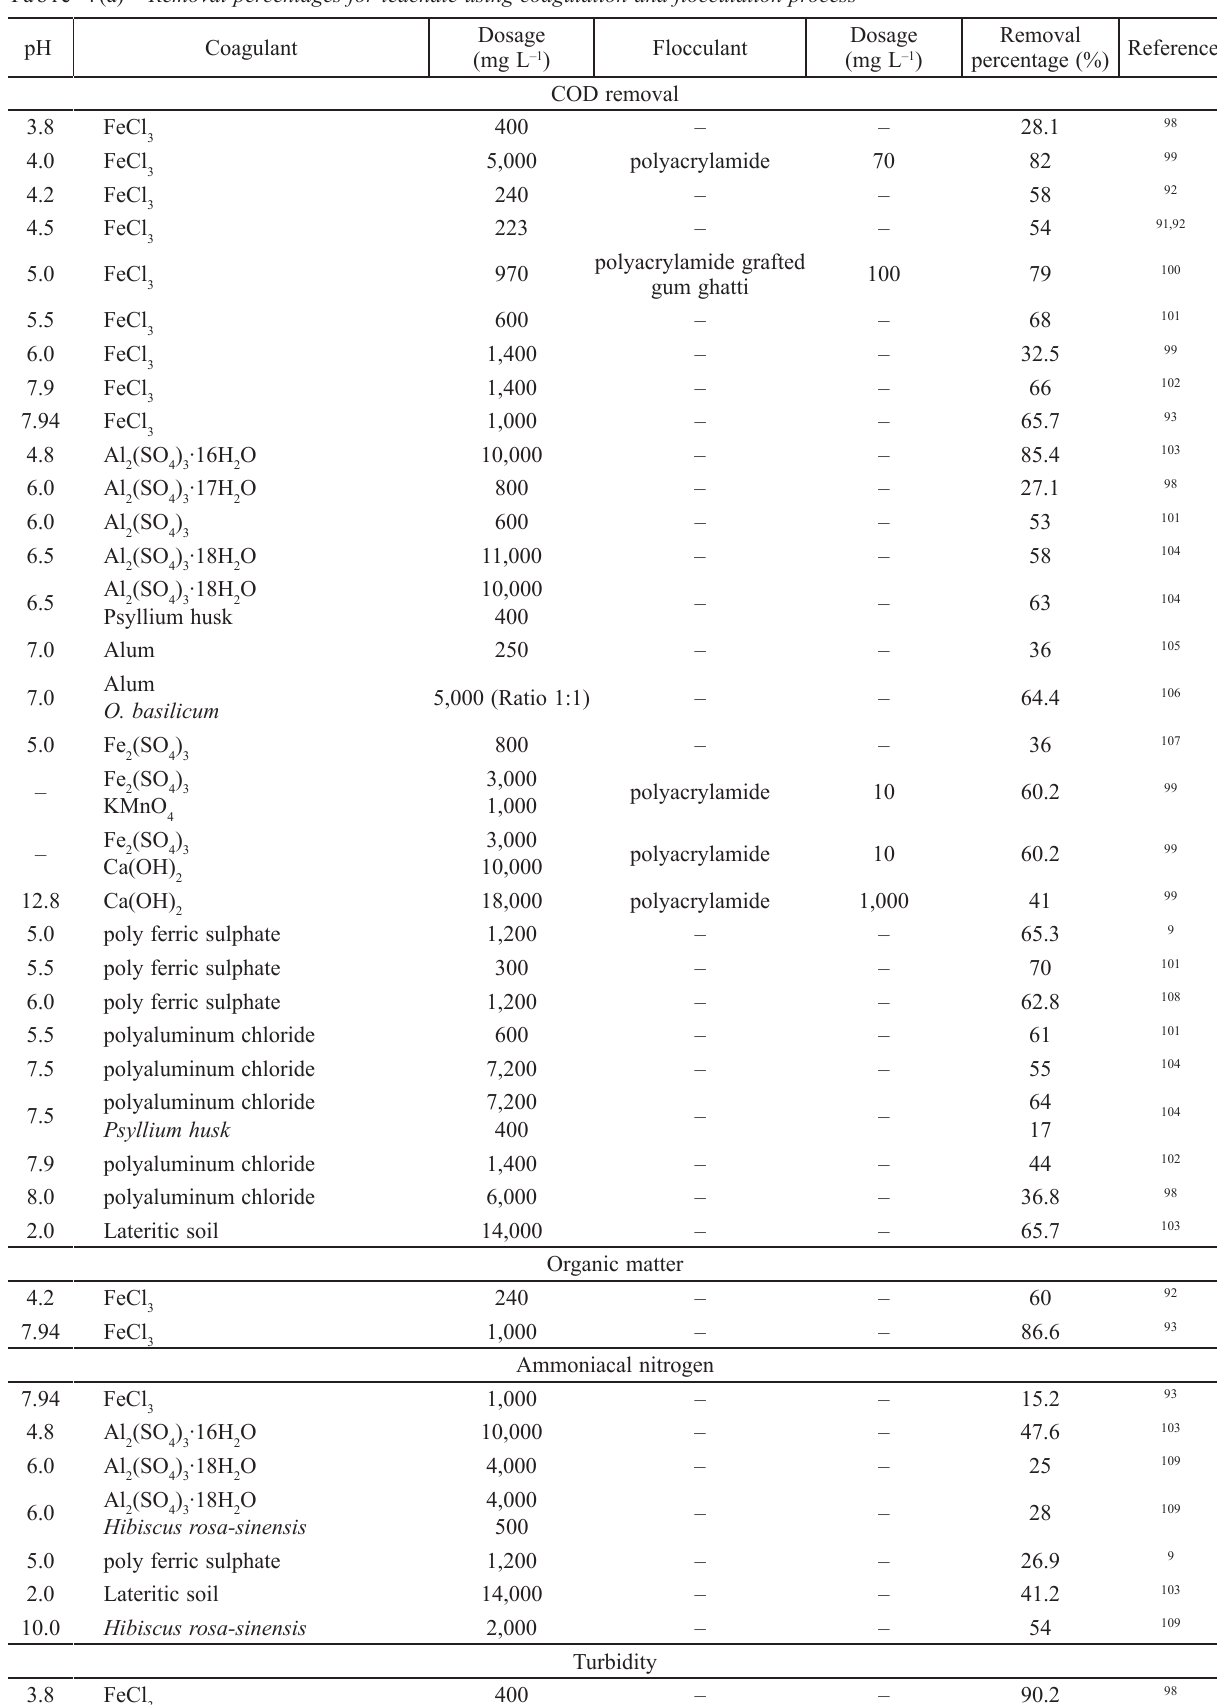
Table 4(a) – Removal percentages for leachate using coagulation and flocculation